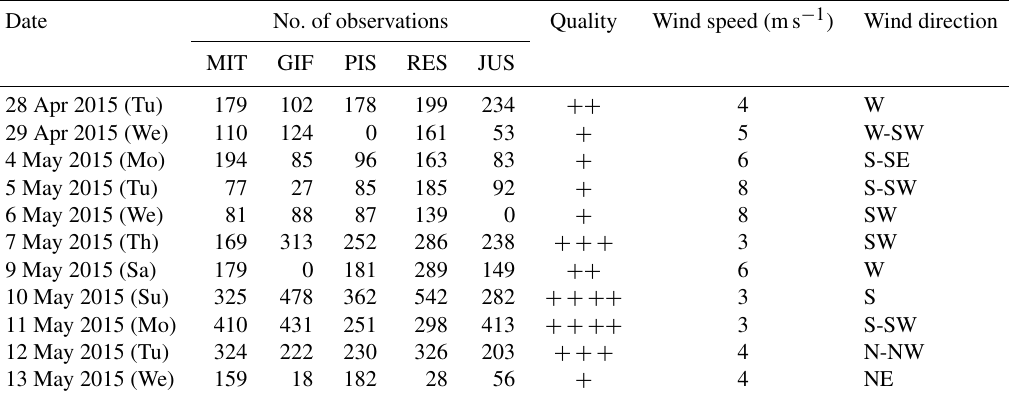
Table 2. Summary of all measurement days with the number of observations at each of the sites, Mitry-Mory (MIT), Gif-sur-Yvette (GIF), Piscop (PIS), Saulx-les-Chartreux (RES) and Jussieu (JUS), the overall quality ranking of each day according to the number of available observations and temporal coverage (with classification from poor to great: + , ++ , +++ , ++++ ) , and the ground-level wind speed and direction.